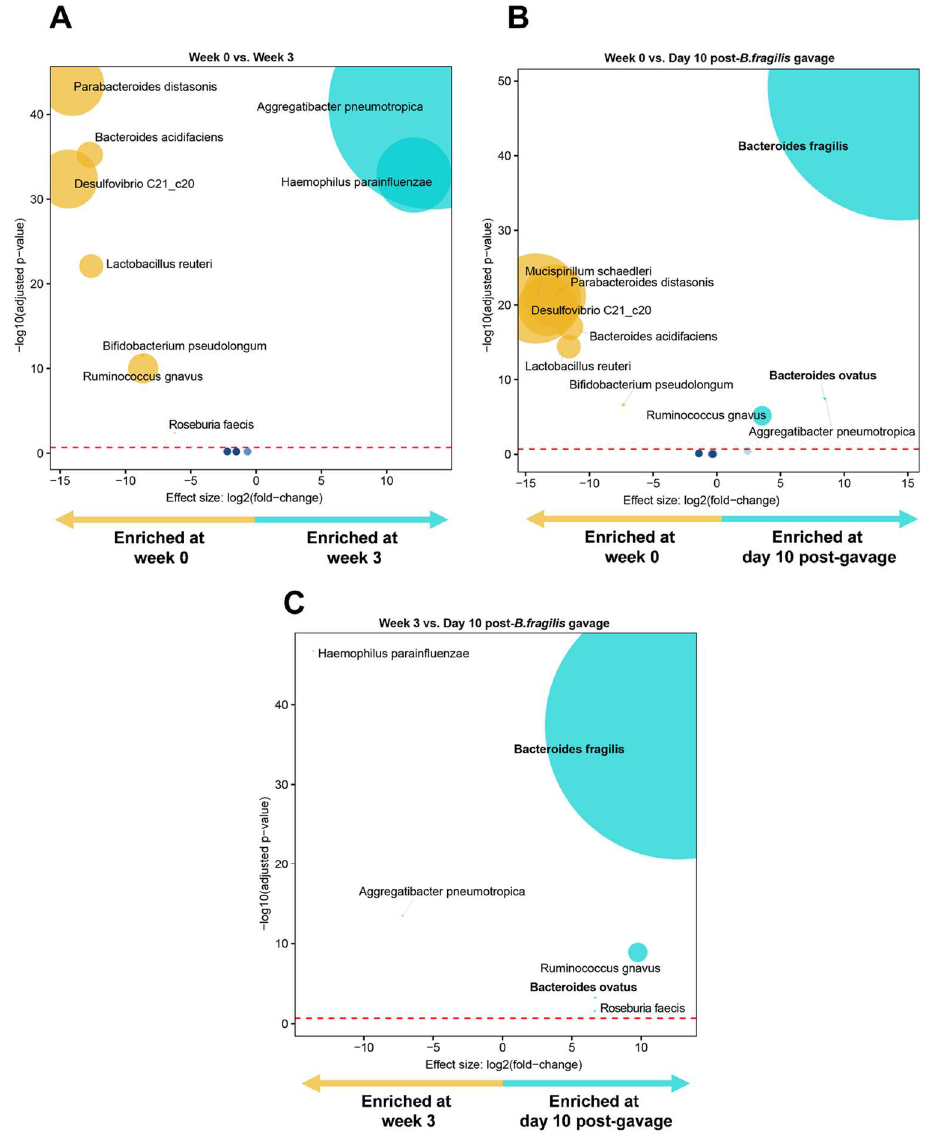
Figure 8. Volcano plots depicting differentially abundant taxa following transplantation of B. fragilis into MC-treated mice as determined by DESeq2 at ( A ) week 0 versus week 3, ( B ) week 0 vs. day 10 post-treatment, and ( C ) week 3 versus day 10 post-treatment. Significantly more discriminatory taxa appear closer to the left or right and are above the threshold (red dotted line, false discovery rate = 0.2). Relative abundance of taxa is indicated by circle size. Bacteroides spp. is